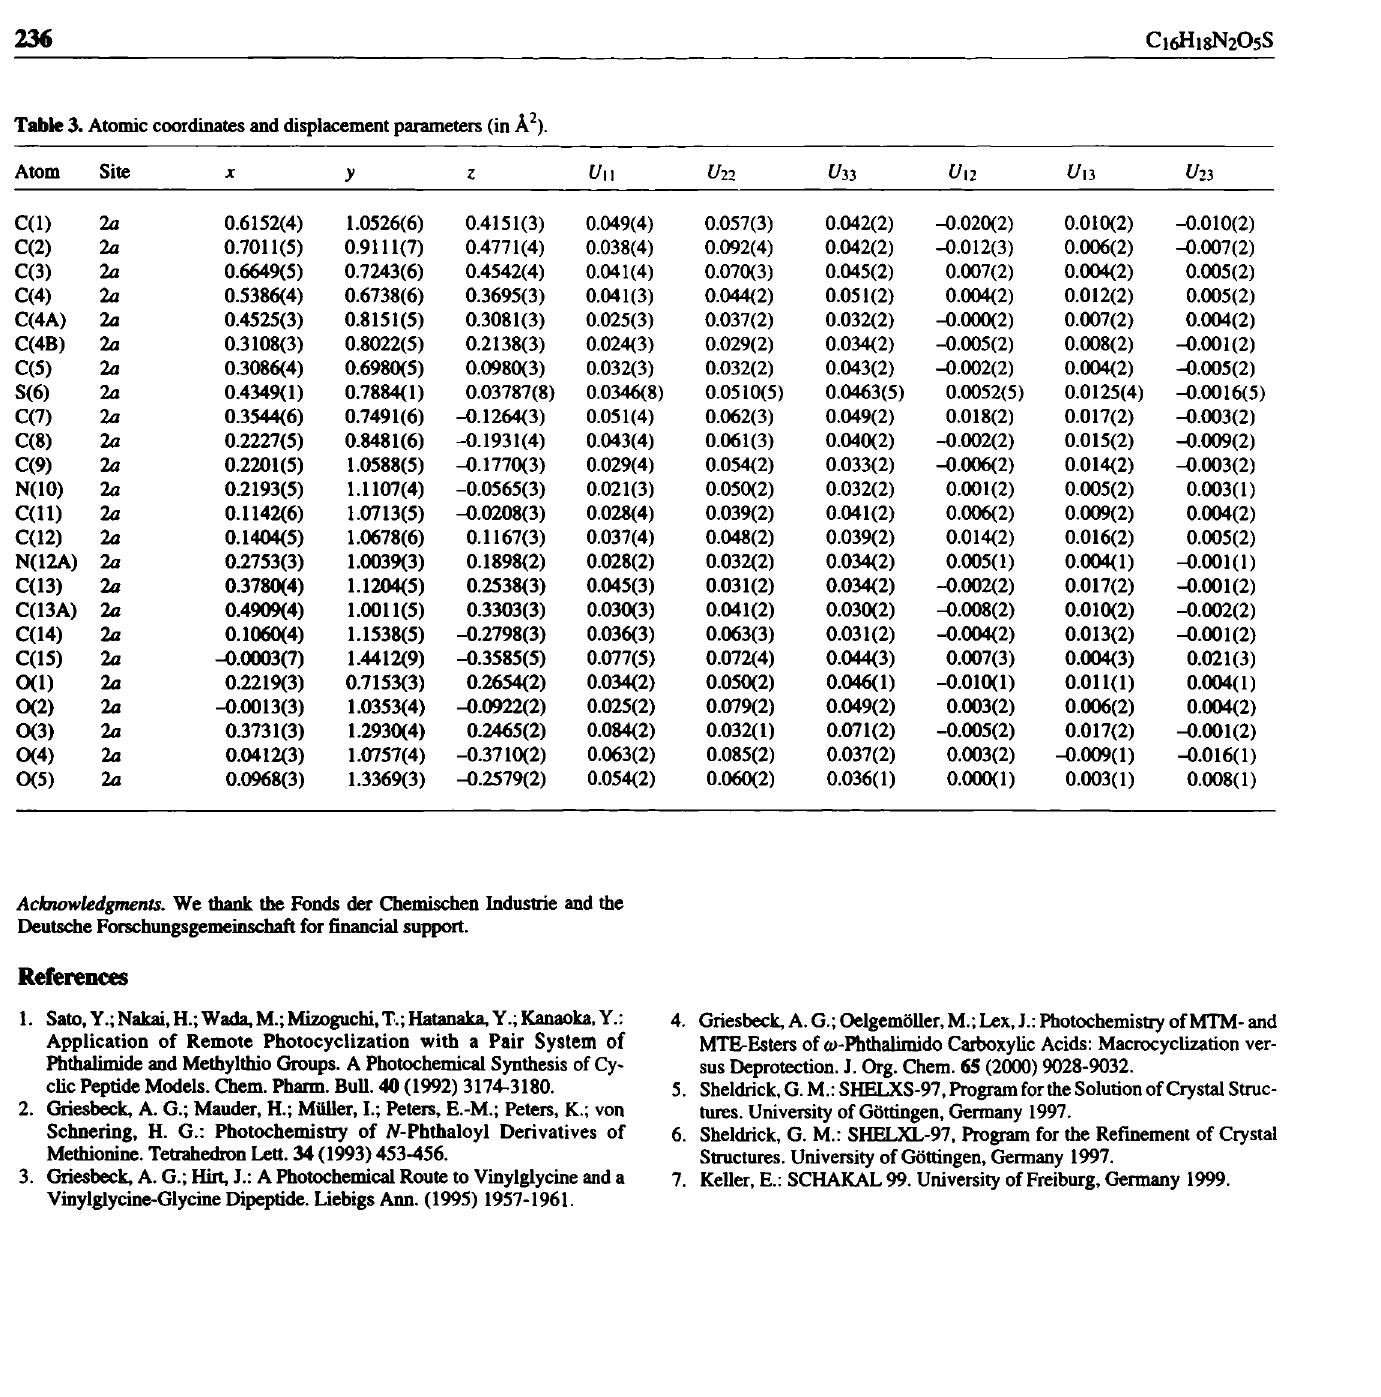
Table 3. Atomic coordinates and displacement parameters (in Â 2